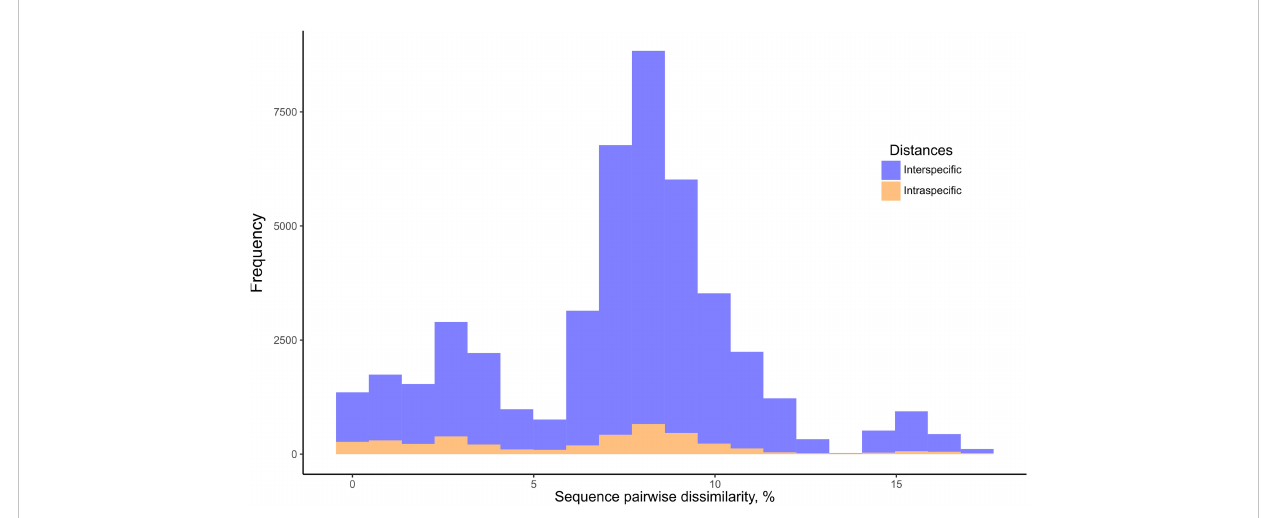
FIGURE 4 Frequency distribution of intraspeci fi c and interspeci fi c distances of Biomphalaria partial coi sequences. Histogram of intraspeci fi c (orange) and interspeci fi c (blue) distances based on the Biomphalaria partial coi sequences. Pairwise K2P distances were expressed as percentage dissimilarity (K2P *